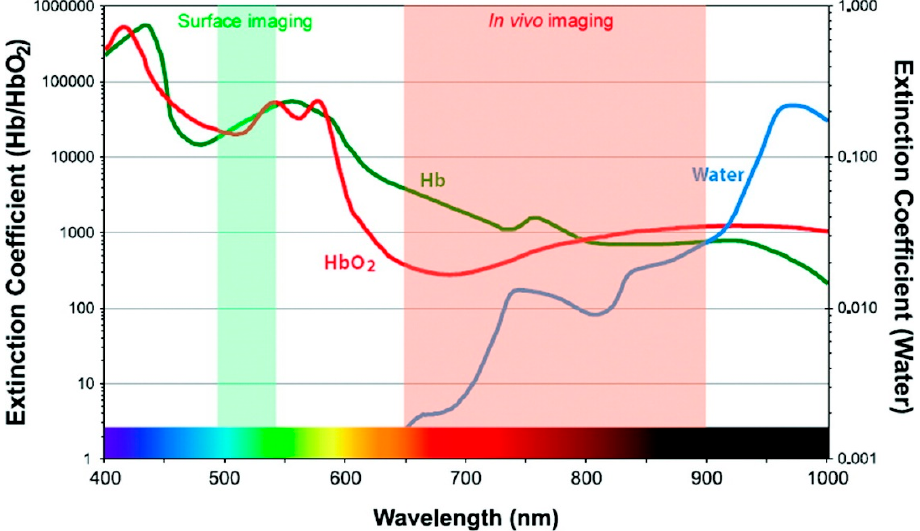
Figure 4. Extinction coefficient values of water and oxy- and deoxyhemoglobin across wavelengths of light used for imaging. Reprinted with permission from [44]. Copyright 2010, American Chemical Society.